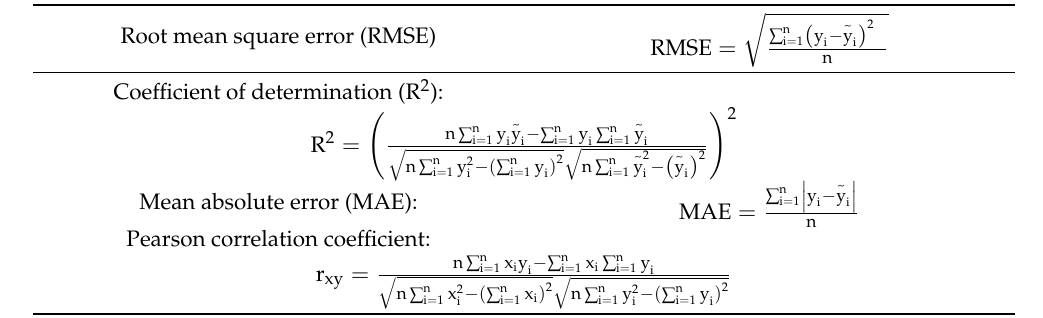
Table A1. Metrics of Model